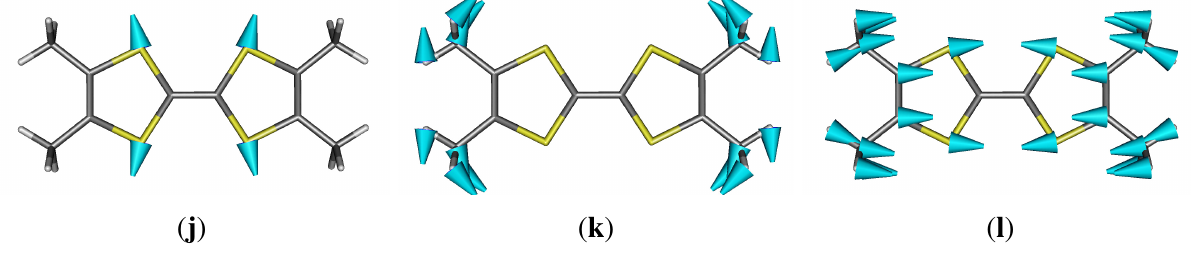
Figure A3. Eigenvectors of the eleven ungerade ( b